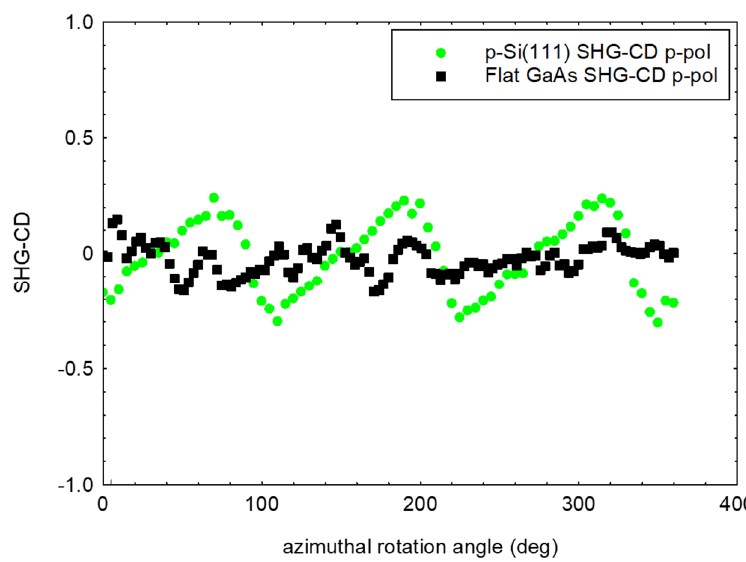
Figure 4. SHG-CD signal of the p-Si(111) reference and of the flat GaAs substrate. In the measurements the azimuthal rotation angle is relative.